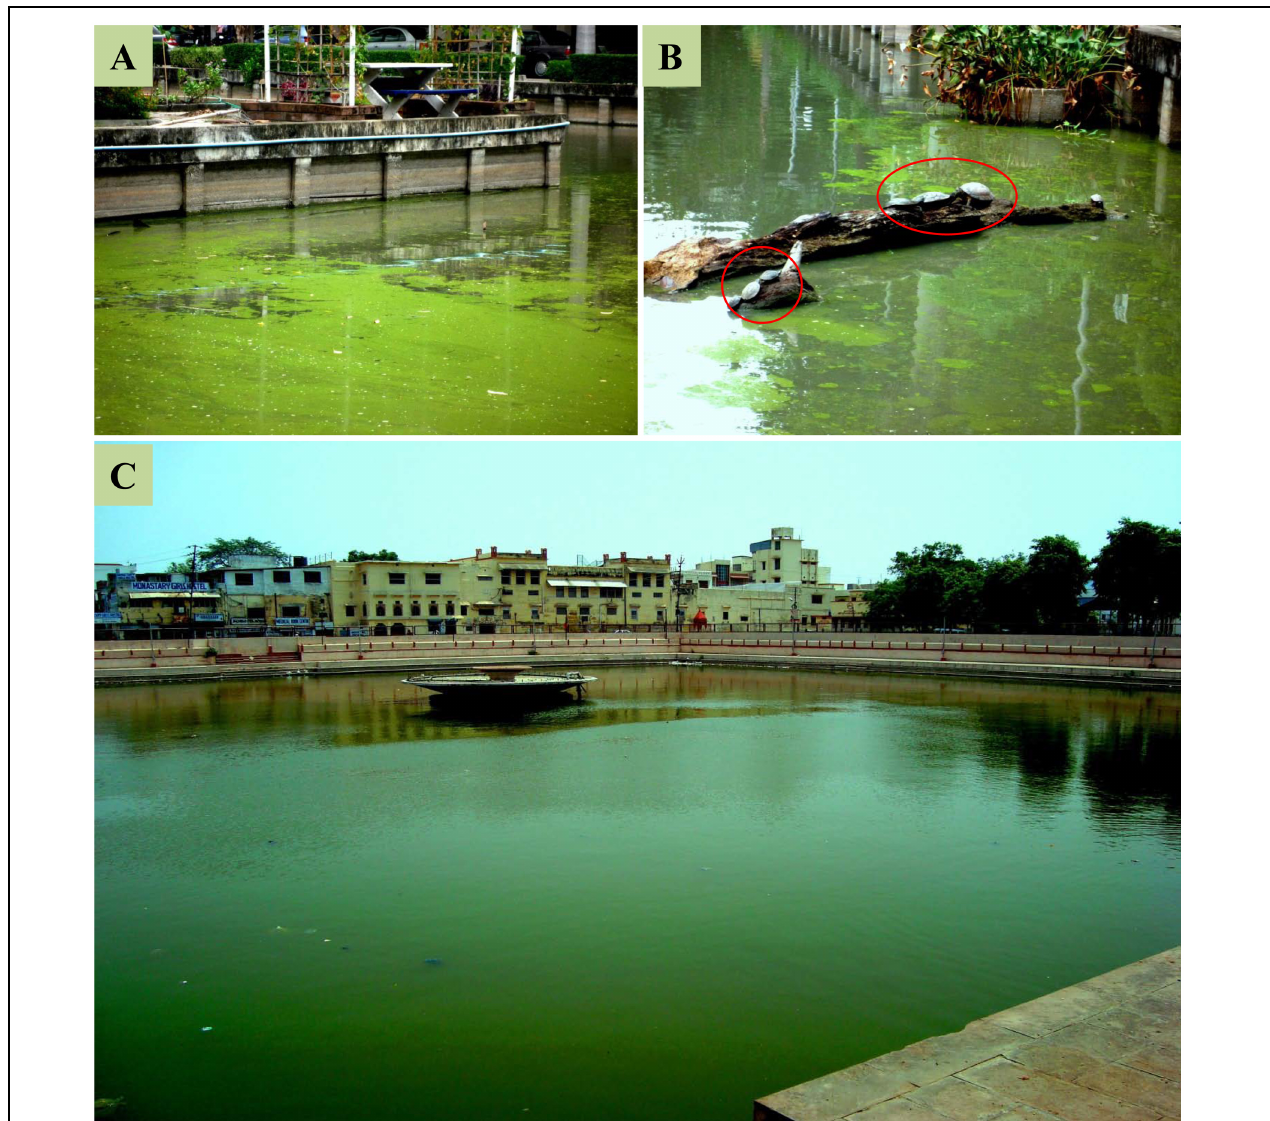
FIGURE 1 | Examples of excessive nutrient enrichment and bloom dynamics in freshwater ponds. (A) Harmful algal blooms in a pond at Chulalongkorn University, Bangkok, Thailand, showing the life of turtles (in red circle) under the toxic blooms condition (B) . (C) Harmful algal blooms in a large pond in Varanasi, India (Photograph by R.P.